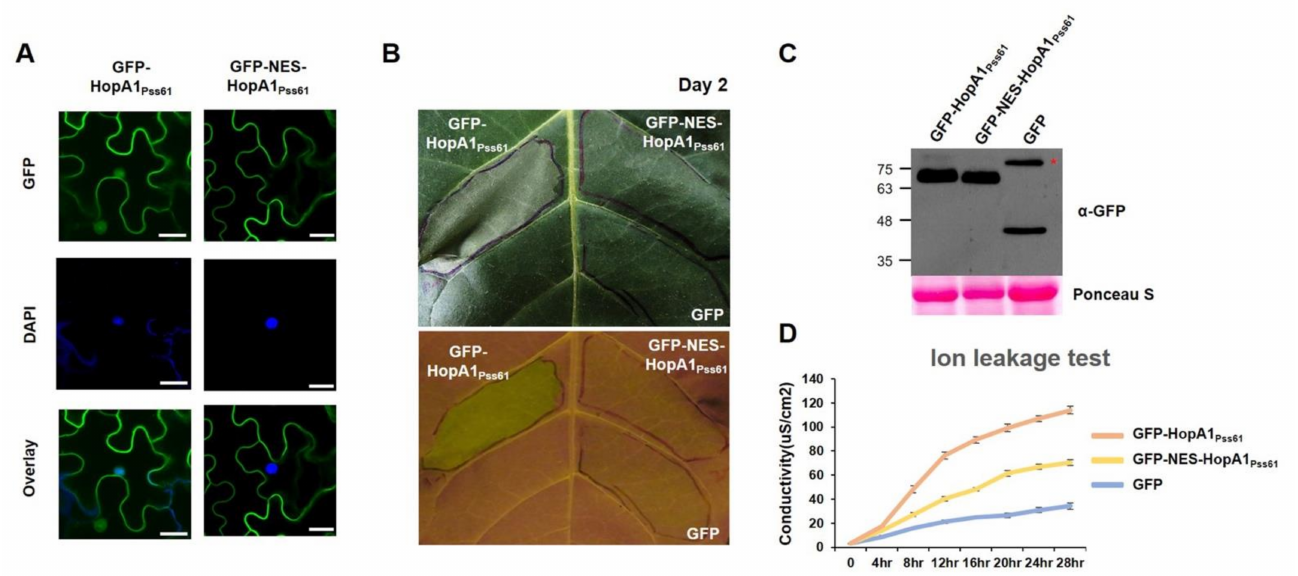
Figure 3. The nuclear pool of HopA1 Pss61 is required for ETI responses. ( A ) GFP- HopA1 Pss61 and GFP-NES- HopA1 Pss61 constructs were transiently expressed in N. benthamiana leaves using Agrobacterium adjusted to an OD 600 of 0.2. Two days after infiltration, leaf discs were stained with 4 (cid:48) ,6-diamidino-2-phenylindole (DAPI) for nucleus detection. Two days after infiltration, cells expressing fusion proteins were analyzed by an Olympus fluoview FV1000 confocal microscope under GFP fluorescence (top), DAPI (middle), and GFP/DAPI overlay (bottom). Scale bar: 20 µ m. ( B ) GFP-hopA1 Pss61, GFP-NES- HopA1 Pss61 , and GFP constructs were transiently expressed in N. tabacum cv. Xanthi leaves using Agrobacterium adjusted to an OD 600 of 0.2. The photographs were taken under visible light (top) and UV light (bottom) at 2 days post-inoculation; ( C ) Detection of HopA1 protein by Western blot. Expression of GFP- HopA1 Pss61 , GFP-NES- HopA1 Pss61 , GFP in samples shown in ( A ) and ( B ) was confirmed by Western blot with anti-GFP antibody. Total protein was extracted from six leaf discs at 2 days post-inoculation. Total protein staining (Ponceau S) confirmed equal loading in Western blot analysis. The asterisk indicates a non-specific band cross-reacting with the anti-GFP antibody; ( D ) Quantification of cell death triggered by the hopA1 constructs described in ( B ) using electrolyte leakage. Error bars indicate standard deviation. Conductivity was measured at the indicated time points. This experiment was repeated twice with a similar